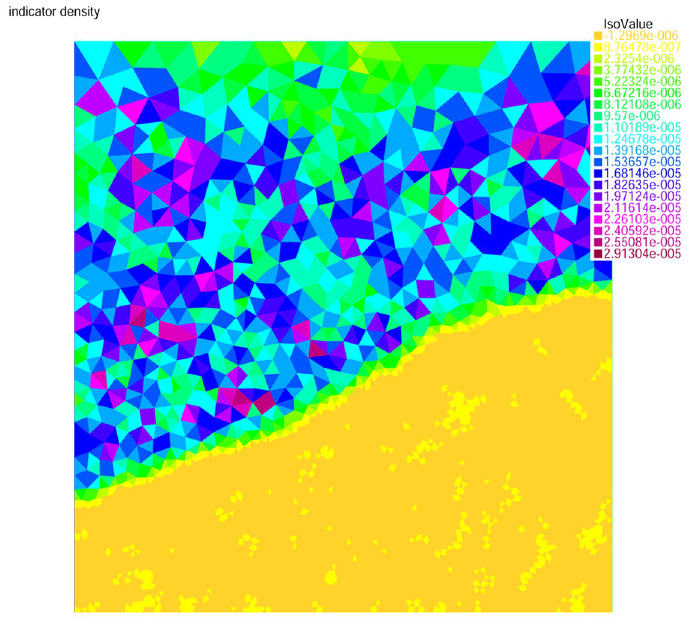
Fig 12. Density of error indicator for experiment 6.